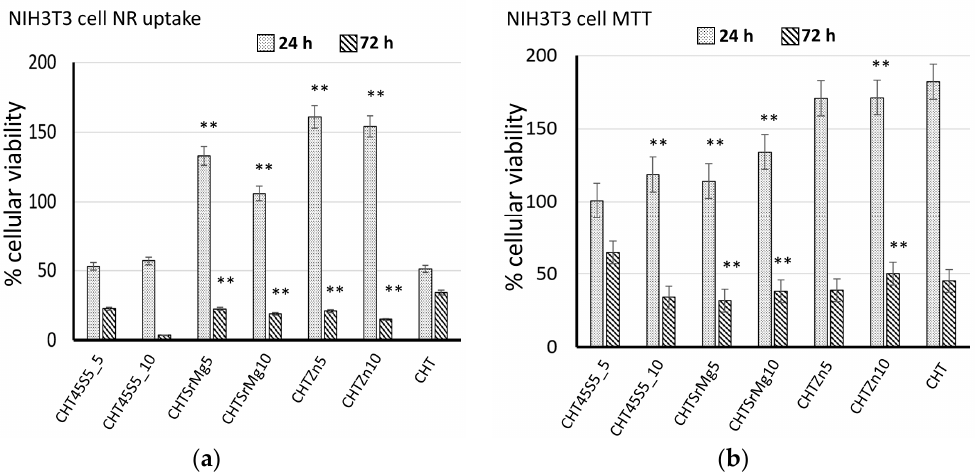
Figure 6. Neutral red (NR) uptake 24 and 72 h after seeding ( a ); MTT 24 and 72 h after NIH 3T3 cultured in eluates from wound dressings ( b ). ** p < 0.05.